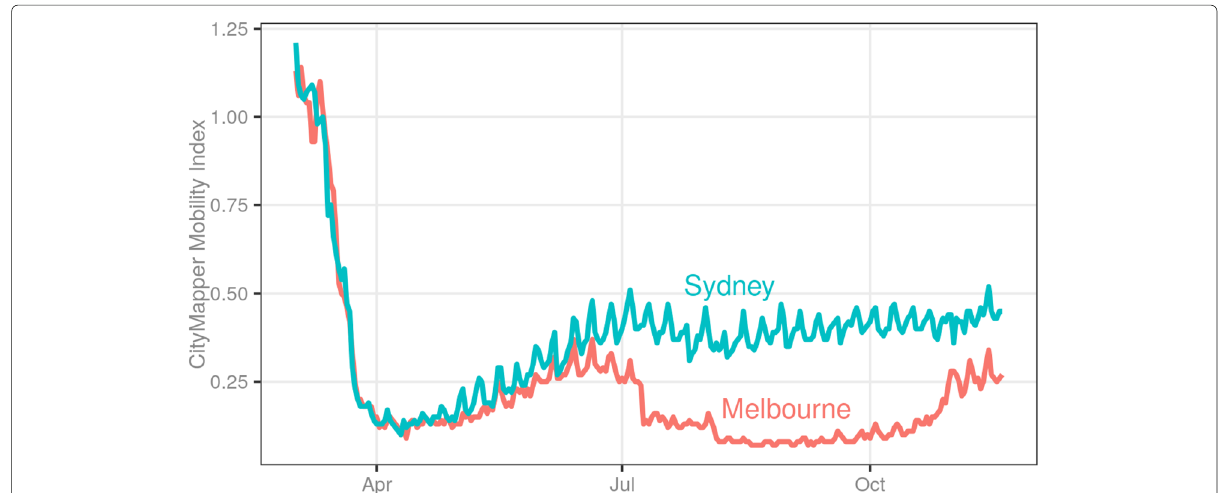
Fig. 6 Fall and recovery of the CityMapper mobility index in Melbourne and